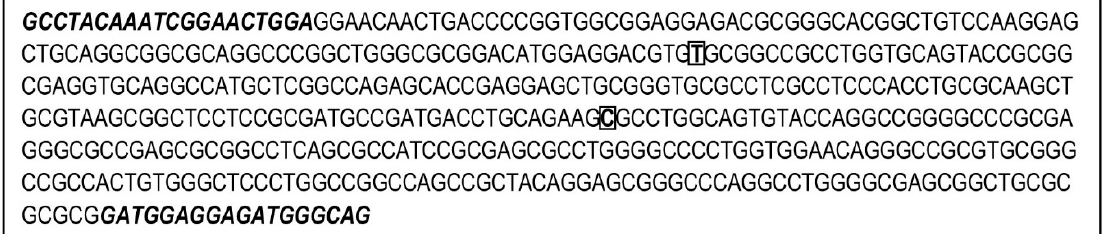
Figure 1. Sequenced region for Apolipoprotein E ( APOE ) including single nucleotide polymorphisms (SNPs) rs429358 (squared T in figure) and rs7412 (squared C in figure). Sequence downloaded from UCSC Genome Browser (https://genome.ucsc.edu) Assembly Dec. 2013, GRCh38/hg38, Chr19: 44908567-44909018. Designed forward and reverse primers for amplification and sequencing of target region are represented in italic and bold.